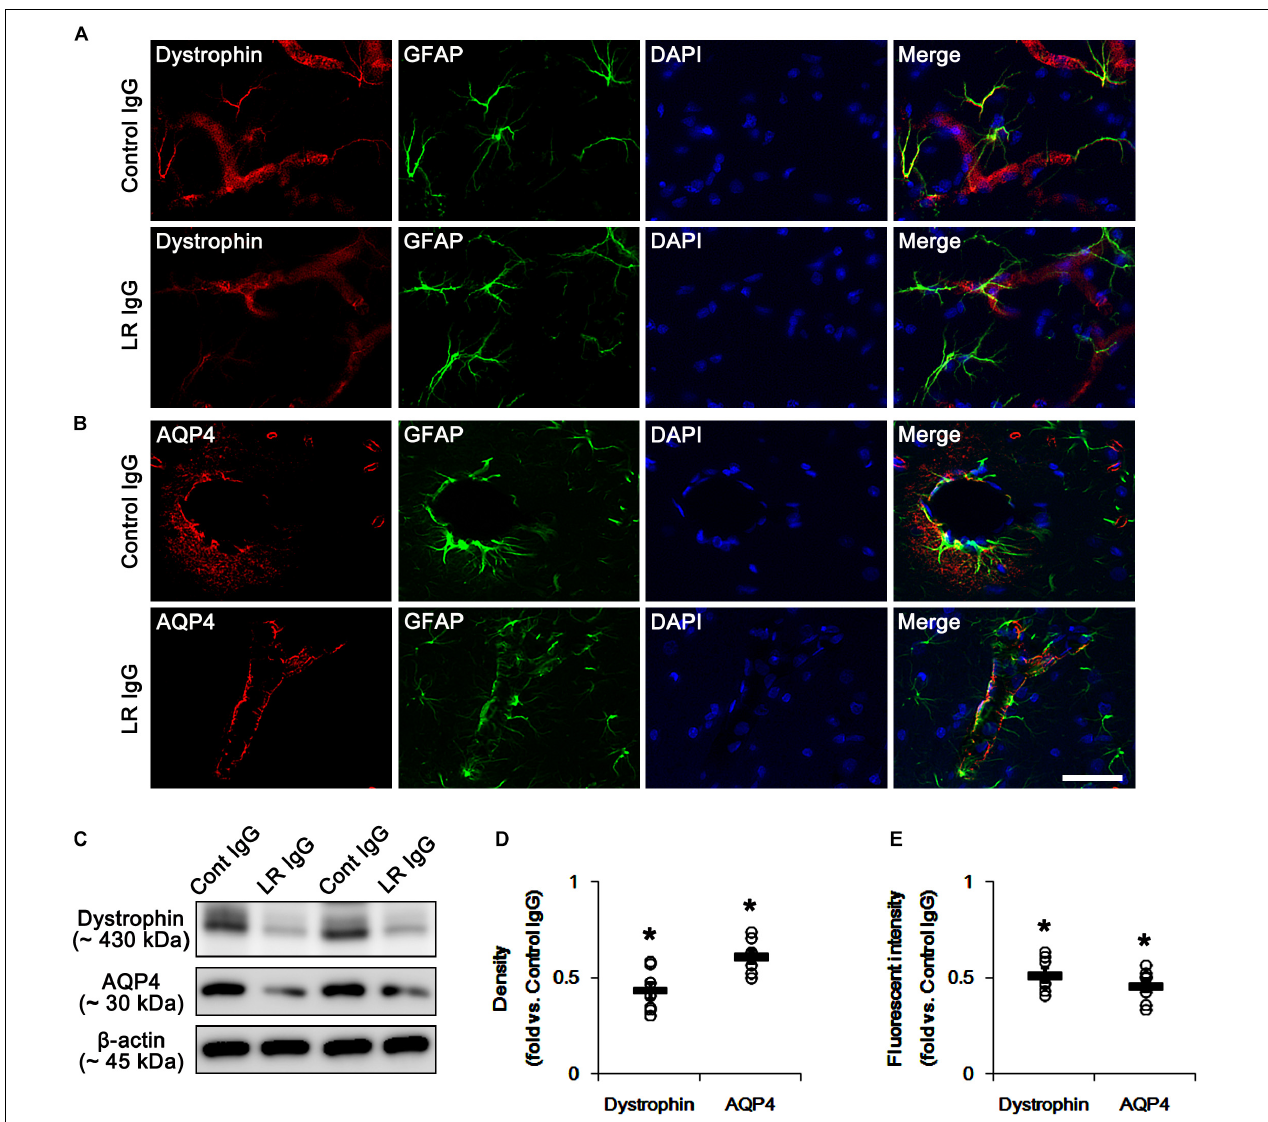
FIGURE 4 | Effect of 67-kDa LR (LR) neutralization on dystrophin and AQP4 expression in the PC of normal animals. (A,B) Representative photographs of dystrophin (A) and AQP4 (B) expressions in the PC. As compare to vehicle, 67-kDa LR neutralization leads to the reduction in dystrophin and AQP4 expressions in the PC. Bar = 12.5 µ m. (C) Western blot image for expression levels of dystrophin and AQP4. (D,E) Quantitative values (mean ± S.E.M) of the Western blot data (D) and the fluorescent intensities concerning expression levels of dystrophin and AQP4 induced by 67-kDa LR neutralization ( n = 7, respectively). Open circles indicate each individual value. Horizontal bars indicate mean value. Significant differences are ∗ p < 0.05 vs. control IgG (Student t